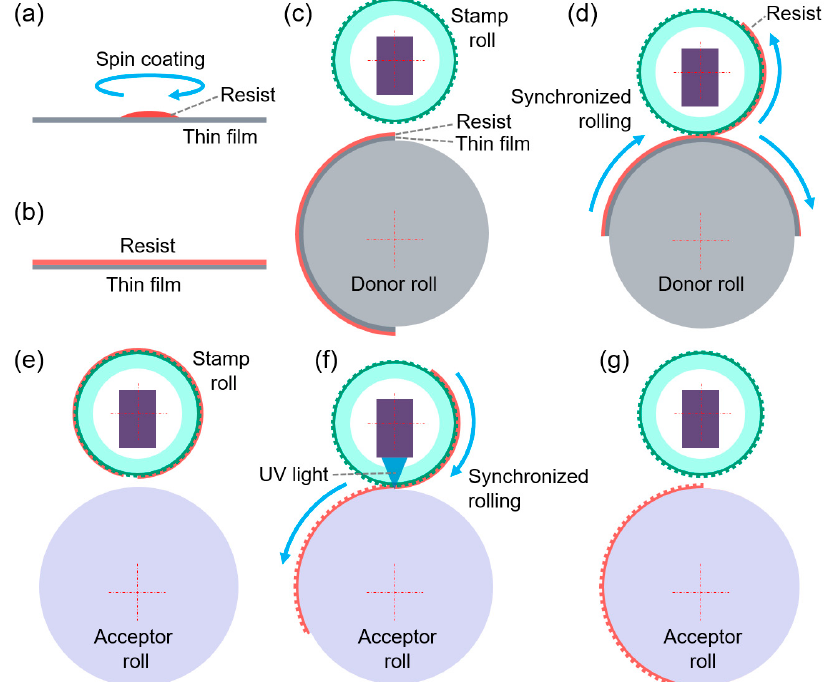
Figure 1. The process for fabrication of large-area roll molds by liquid transfer imprint lithography. ( a ) Resist is dispensed on a thin film, and the film is spun to make uniform thin coating; ( b ) the resist-coated thin film; ( c ) the resist-coated thin film is wrapped onto the donor roll; ( d ) the stamp roll takes up the resist by splitting from a donor roll; ( e ) the stamp roll with the resist is moved to the acceptor roll; ( f ) the resist of the stamp roll is transferred to an acceptor roll while the two rolls rotate synchronously and UV light illuminates; ( g ) a single step of the liquid transfer imprint lithography is